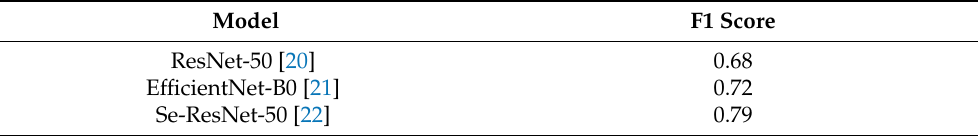
Table 1. Performance of the models for Diabetic Retinopathy (DR) severity.